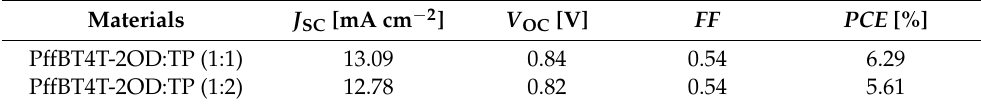
Table 1. Device characteristics of PffBT4T-2OD:TP